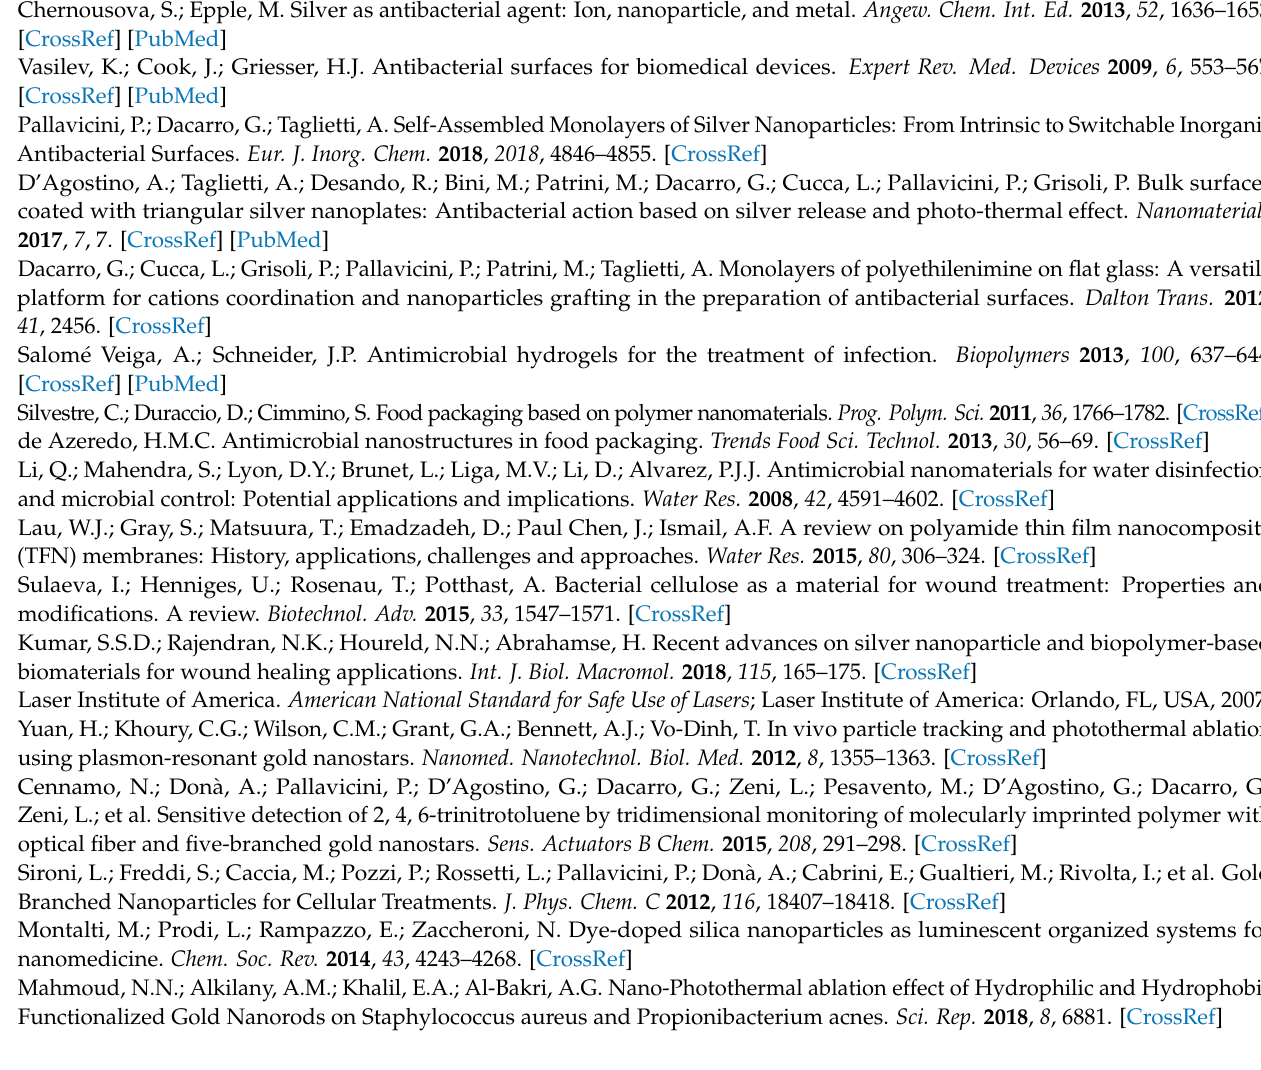
Figure S8: SEM images of adhering E. coli , Figure S8: Fibroblasts vitality